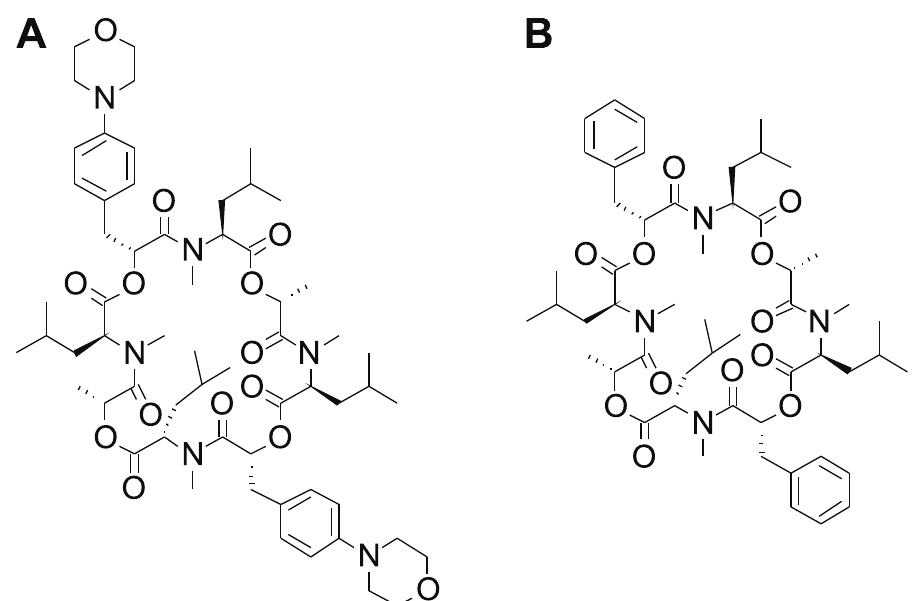
Fig 1. Chemical structures of the semisynthetic emodepside (A) and its precursor PF1022A (B) purified from Rosellinia spp.